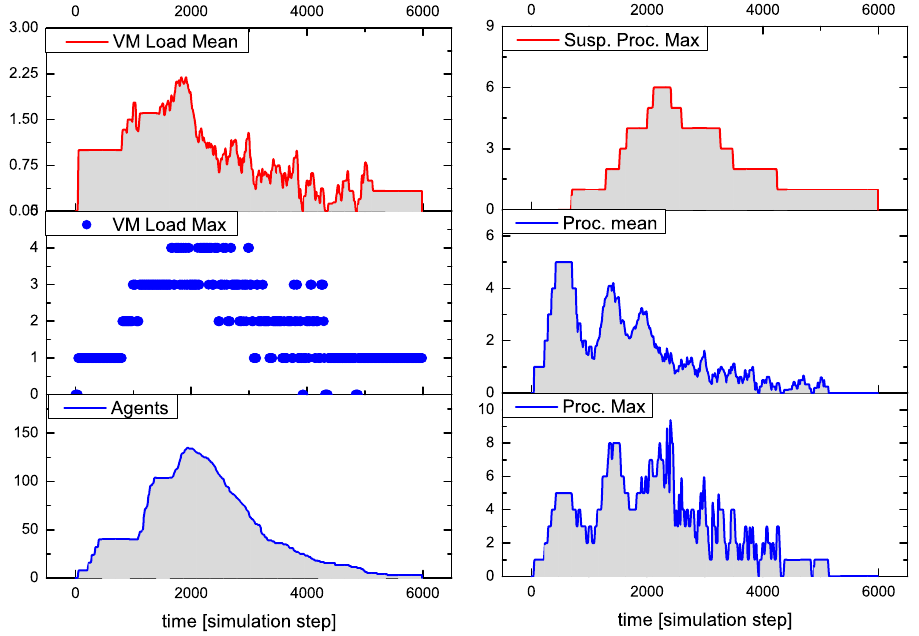
Figure 9. Analysis results for a typical run of the SoS multi-agent system (MAS) with a correlated cluster of 4 × 2 nodes having significant different sensor values compared with the neighborhood (with four VMs/node, the max and mean computation related to nodes in the region of active nodes processing at least one program/agent) (load: the fraction of processing to the idle time of a VM